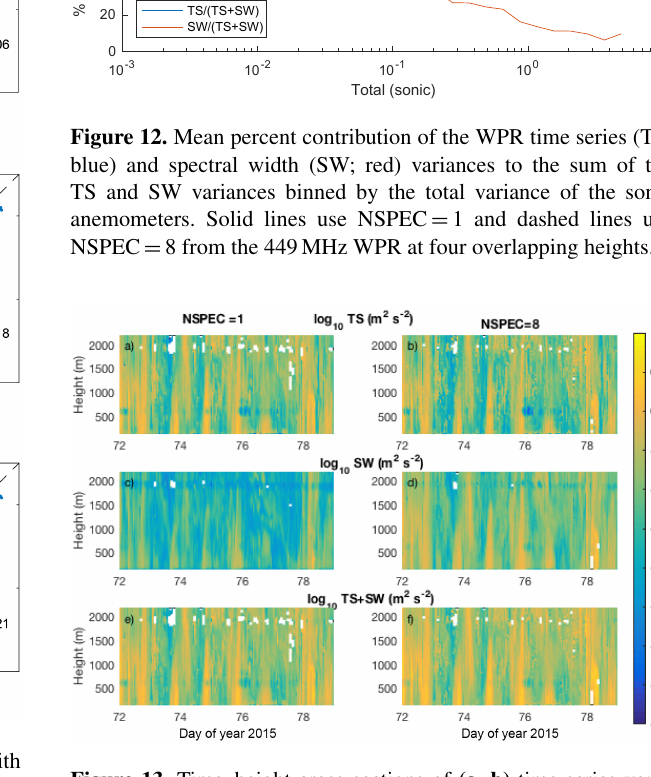
Figure 13. Time–height cross sections of (a, b) time series verti- cal velocity variance, (c, d) spectral width variance, and (e, f) to- tal variance as measured by the 449MHz WPR at the BAO, using NSPEC = 1 (a, c, e) and NSPEC = 8 (b, d, f) , from 13 to 20 March